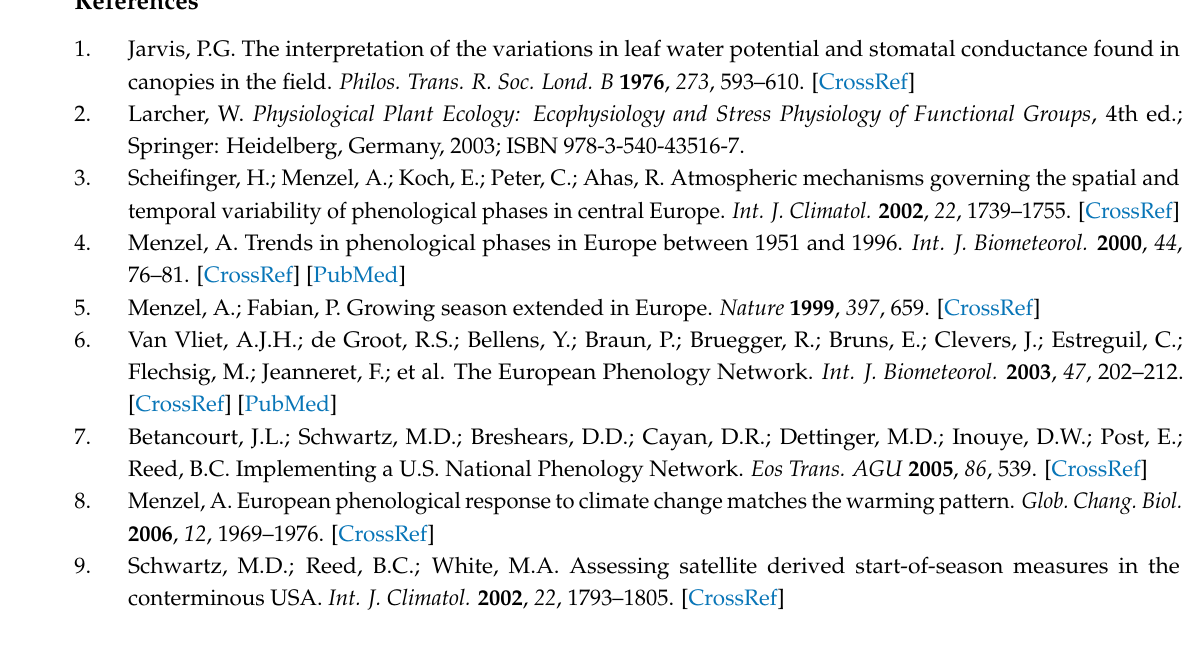
Figure S1: Illustration of the used NDVI time series winter gap filling approach for a pasture area. Figure S2: Yearly mean SOS of the years 2000–2017 for four HLI value ranges representing the quartiles of the data set, Figure S3: Median SOS over the Alps for the years 2001–2017 for different altitudes and the respective trend lines. The formula, correlation coefficient and accuracy level are indicated for the median SOS averaged over all altitudes, Figure S4: Yearly alpine-wide median NDVI of the years 2000–2017 for the ten analyzed CORINE land cover, Figure S5: Yearly SCD of the years 2000–2017 for four HLI value ranges representing the quartiles of the data set, Figure S6: Percentage of all negatively (top) and positively (bottom) correlated pixels between SCD and mean NDVI of the respective same month over the hydrological year (1 October–30 September), Figure S7: Results from cross-correlating 16-day values of NDVI with climate variables for all 2 km by 2 km grid cells in South Tyrol during 2003–2012, Figure S8: Influence of climate variability on NDVI (normalized difference vegetation index), Figure S9: Influence of climate variability on NDVI (normalized difference vegetation index) at different altitude classes, Figure S10: Influence of climate variability on NDVI (normalized difference vegetation index) at different HLI classes, Figure S11: Model metrics of regressing deseasonalized NDVI on deseasonalized climate variables interacted with altitude and HLI (heat load